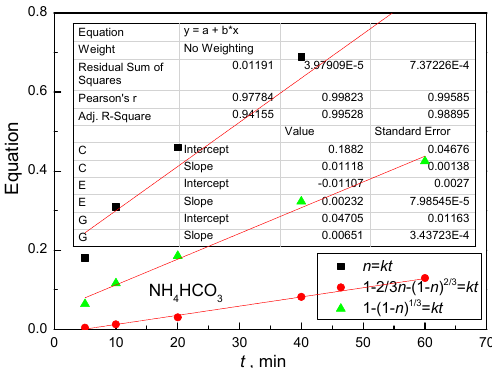
Figure 7. Linear fitting correlations of different rate equations (concentration of sodium carbonate: 1 mol/L, temperature: 60 °C, particle size: 96–120 μ m, stirring rate: 90 rpm).